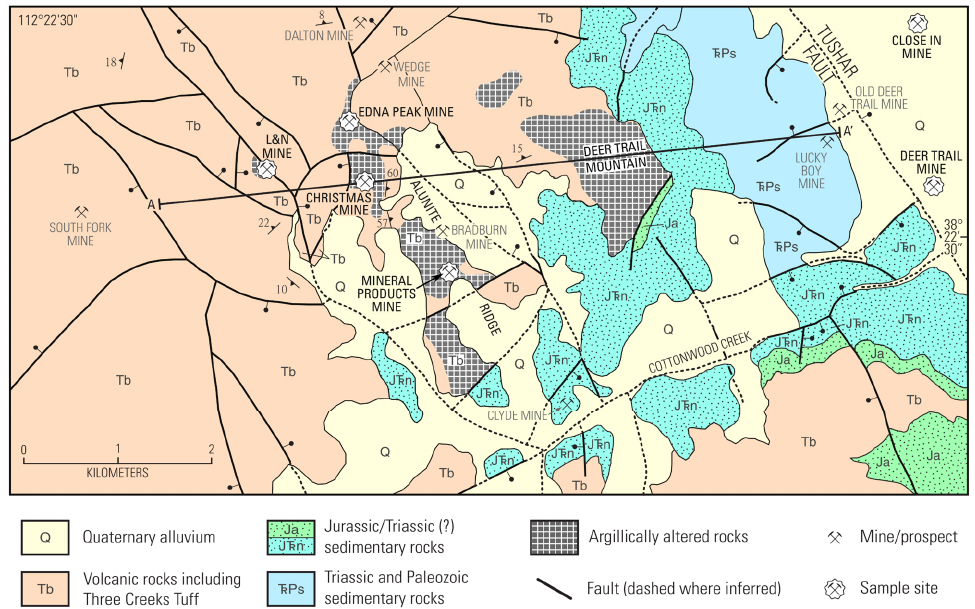
Figure 3. Simplified geologic map with mine locations of Alunite Ridge and Deer Trail Mountain, Marysvale, Utah (modified after Beaty et al. [14]). A felsic dike was collected from the upper Mineral Products mine for zircon U/Pb analyses. Samples of magmatic-steam alunite were collected from the L&N, Christmas, Edna, Mineral Products, and Close In mines/prospects, and sericite was separated from a sample collected from the Deer Trail mine workings for 40 Ar/ 39 Ar dating. Note, the location shown for the Deer Trail mine marks the portal to the workings, which extend ca. 3200 m to the west beneath Deer Trail Mountain [14]. The cross section from A to A (cid:48) is shown in Figure